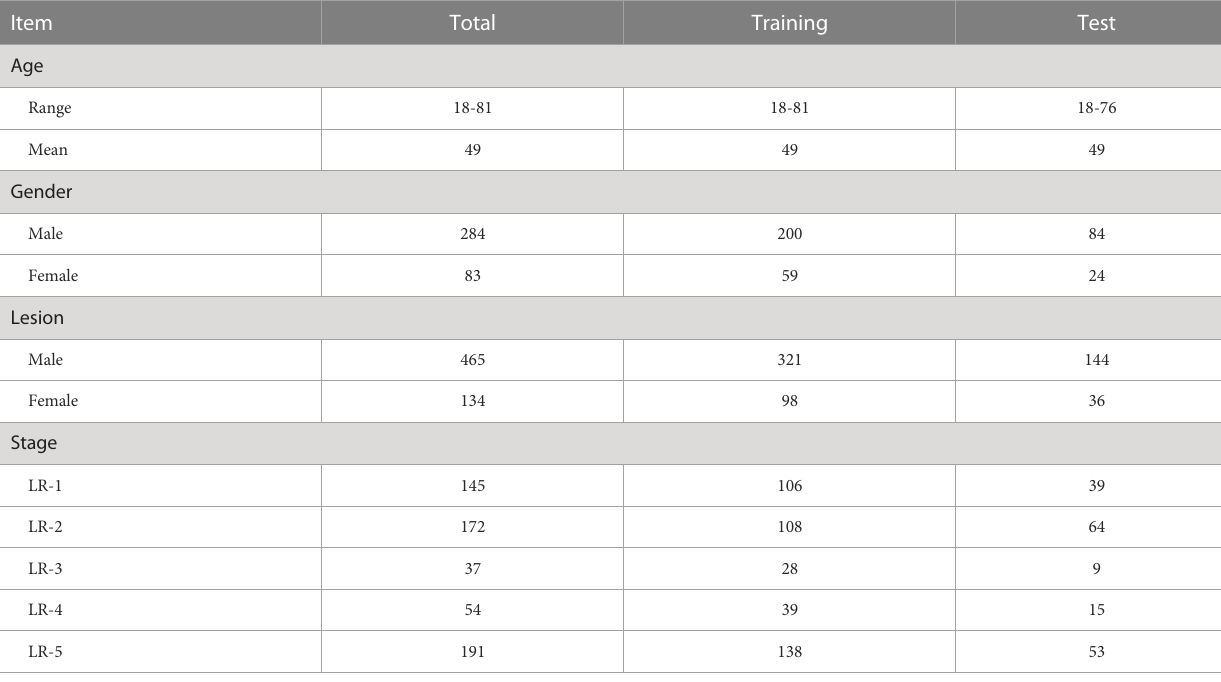
TABLE 1 Characteristics of included HCC patients.